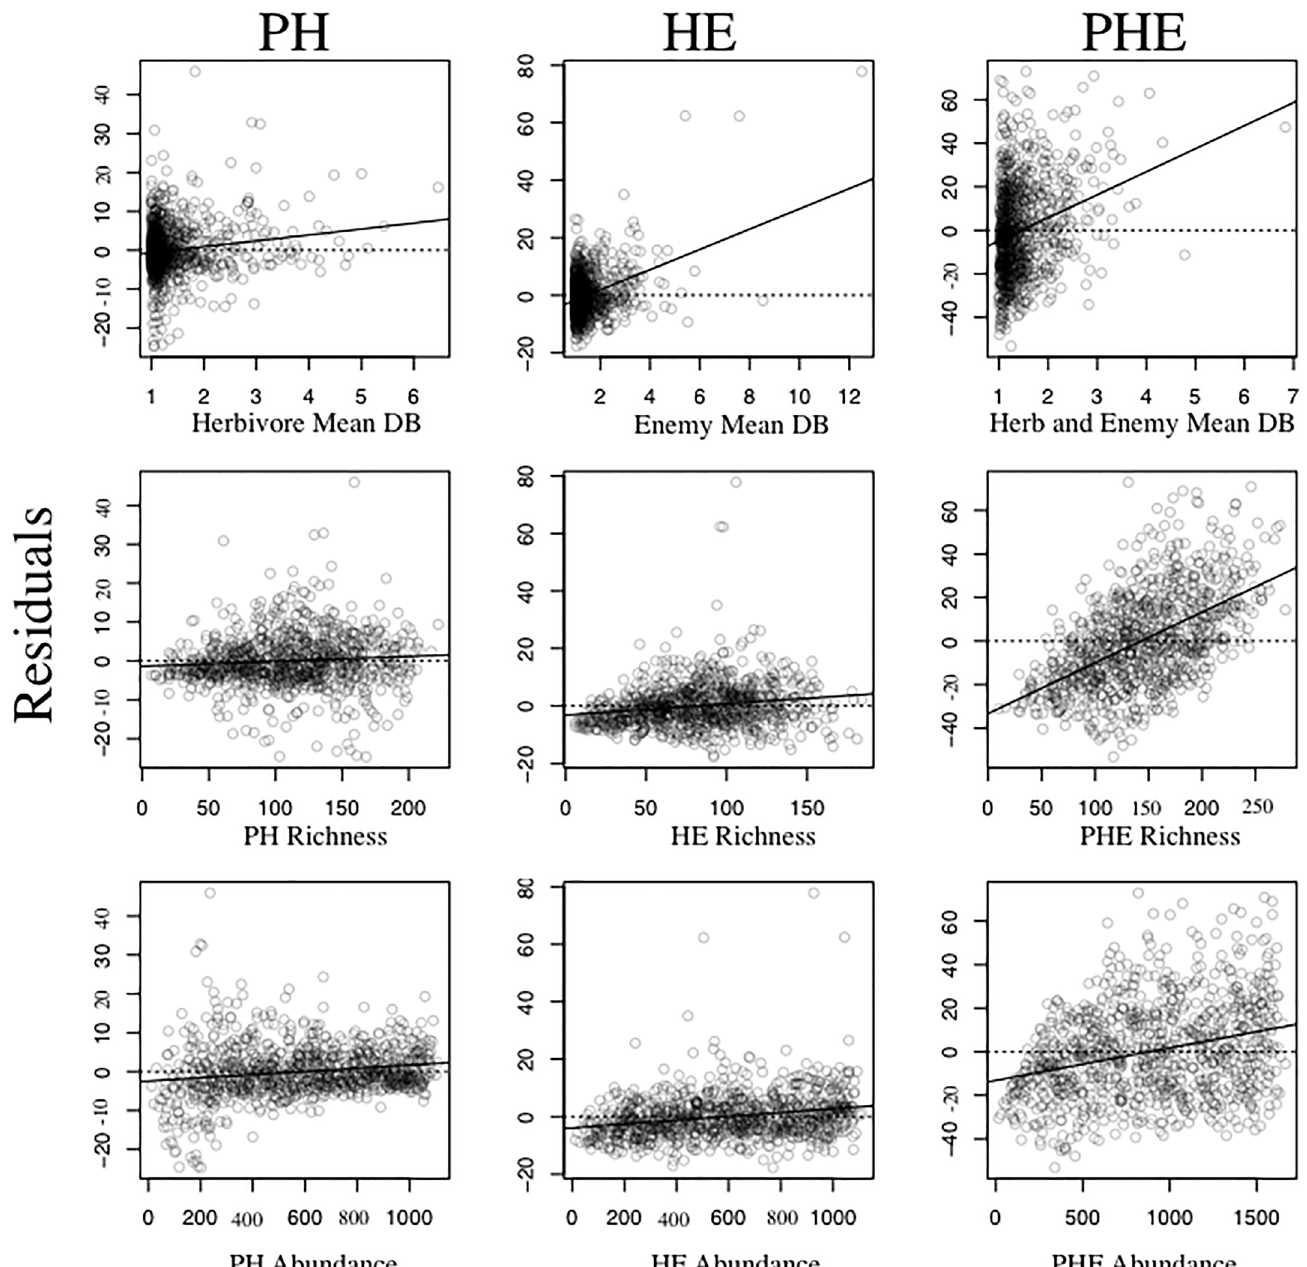
Fig 3. Summary plots of semi-partial correlations between the residuals of species diversity and interaction diversity (these residuals are on the y-axis) and mean consumer diet breadth, species richness, and total abundance (these three parameters are on the x-axis). We investigated this relationship for all three networks (e.g. PH, HE, PHE). The top three panels represent changes in mean diet breadth for each consumer trophic level; mean herbivore and enemy diet breadth were used for the PH and HE networks respectively, while the mean diet breadth for all consumers (herbivores plus enemies) was used for PHE networks. The middle three panels denote community richness for each respective network, which is the total number of species found in all trophic levels. The lower panel displays semi-partial correlations with total community abundance, which equals the sum of all individuals within each trophic level. The solid black lines are least squares regression